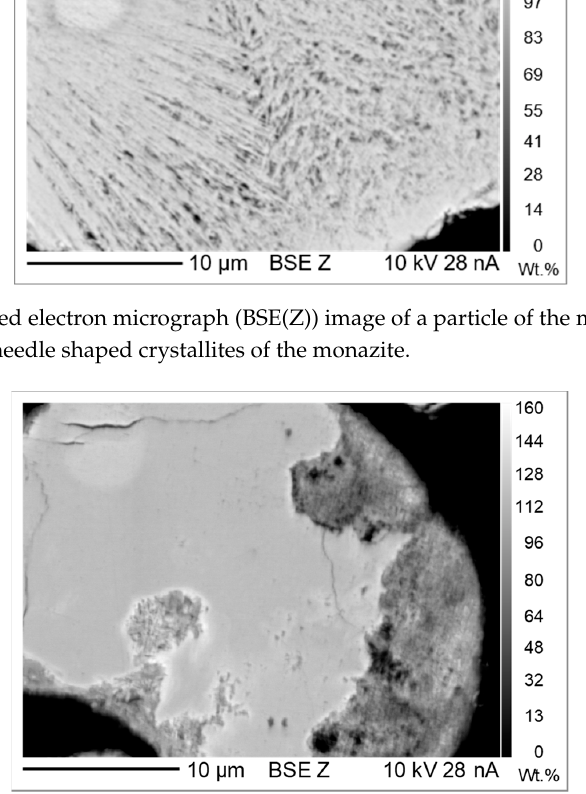
Figure 4. Backscattered electron micrograph (BSE(Z)) of a monazite grain. The edges seem to be damaged by the sulfuric acid treatment.